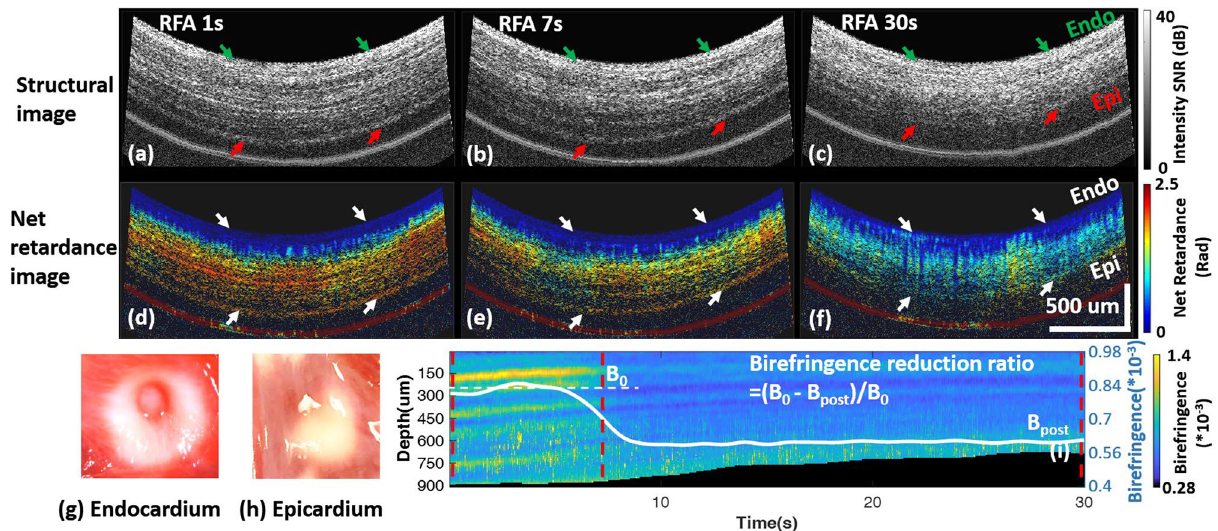
Figure 2. Ex vivo transmural lesion example at the posterior wall monitored with PSOCT. ( a – c ) and ( d – f ) are the structure images and net retardance images, respectively, of the lesion at 1 s, 7 s, and 30 s of ablation; ( g , h ) are photos of the TTC stained lesion on the endocardium and epicardium; ( i ) shows the cross-A-line averaged tissue birefringence change and the averaged tissue birefringence change (white curve). Myo Myocardium, Extra extra-myocardial tissue, Endo endocardium, Epi